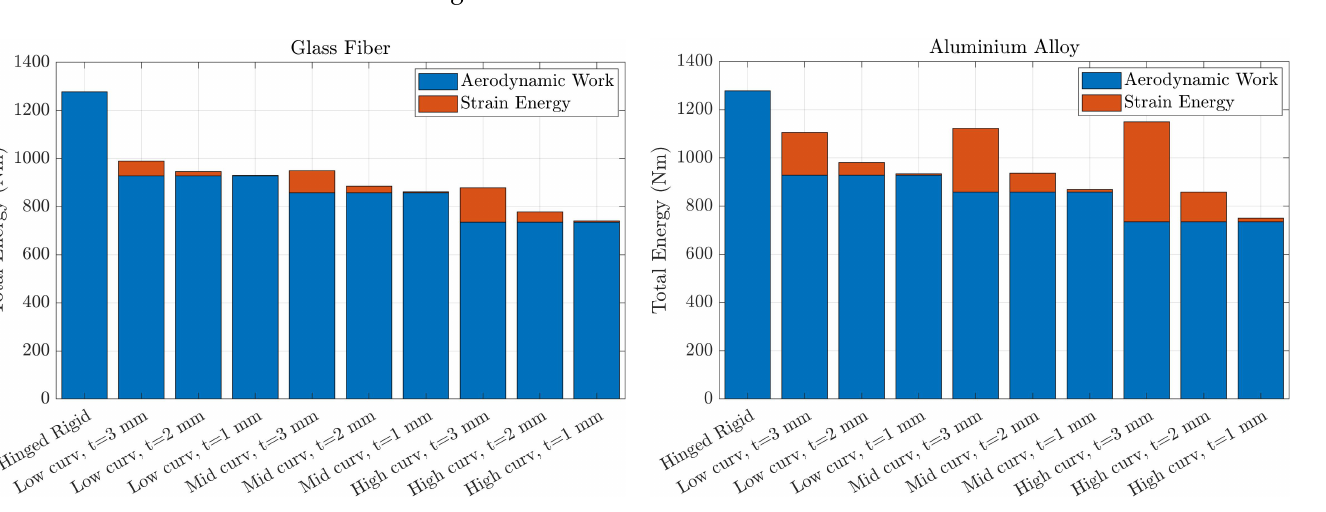
Figure 15. Total energy comparison for skin made of glass-fiber ( left ) and aluminium-alloy ( right ) materials (including transition